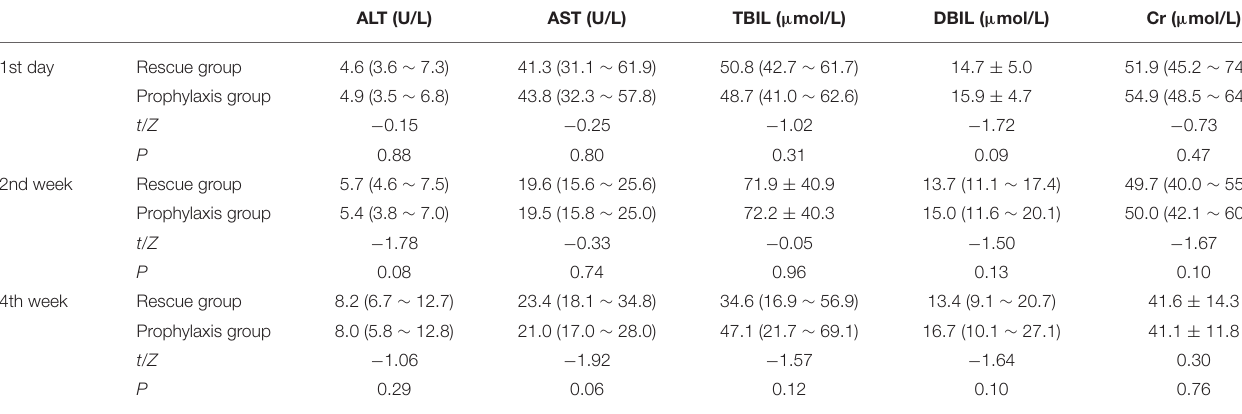
TABLE 4 | Comparison of chemical biomarkers of liver and renal function between two groups.